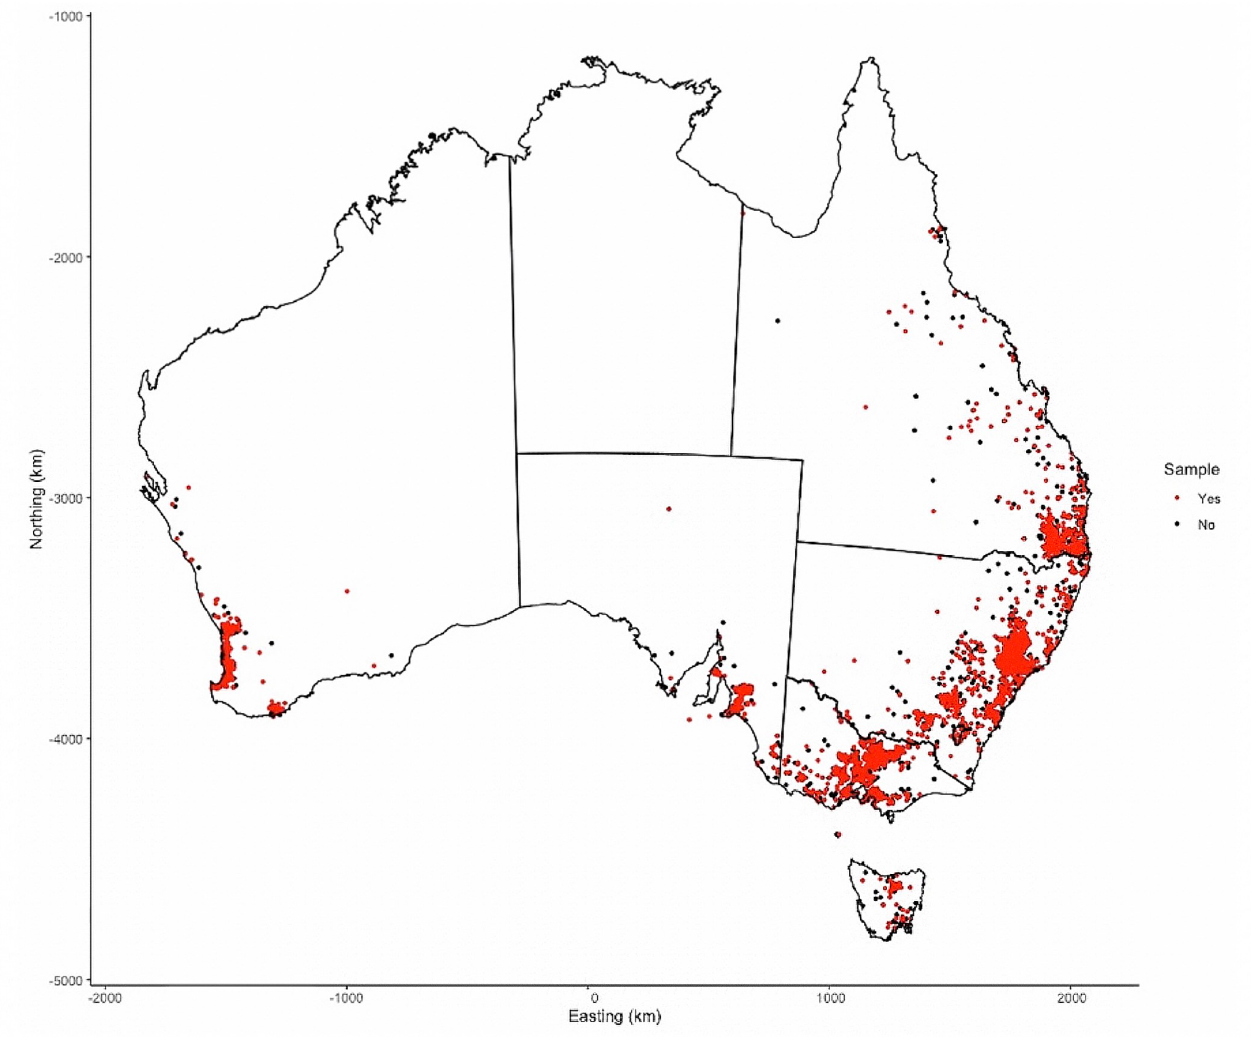
Fig 1. Distribution of the registered place of birth of the 2014 Australian foal crop. Map of Australia showing the location of sampled (red dot ● ) and unsampled (black dot ● ) Thoroughbred stud farms. Red dots are stacked on top of black dots where multiple stud farms exist in a single post code. Derived from Australian Bureau of Statistics [15] under a CC BY 4.0 license, with permission from Australian Bureau of Statistics, original copyright 2016.